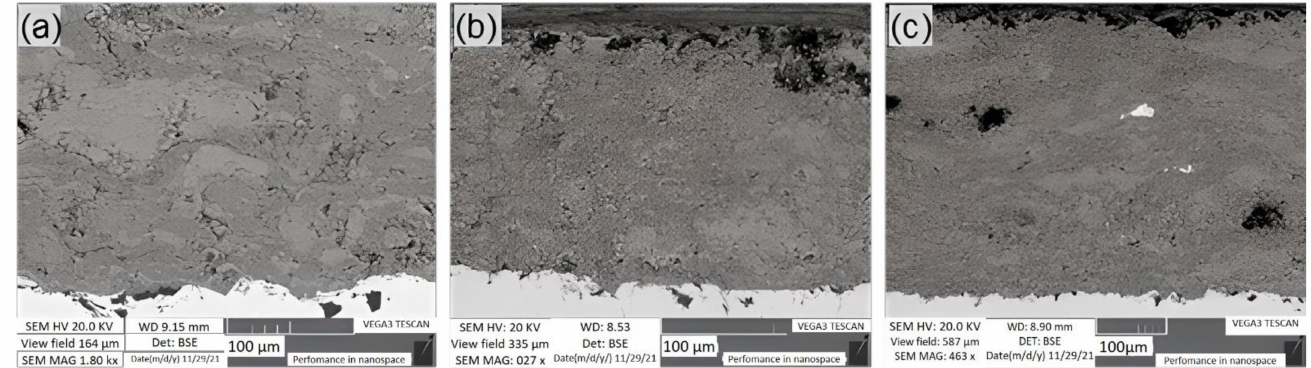
Figure 1. SEM images of cross-sectional morphology of Ti-Si-C coating after pulse-plasma treatment depending on the distance from the plasmatron: ( a ) 30 mm, ( b ) 40 mm, ( c ) 50 mm.